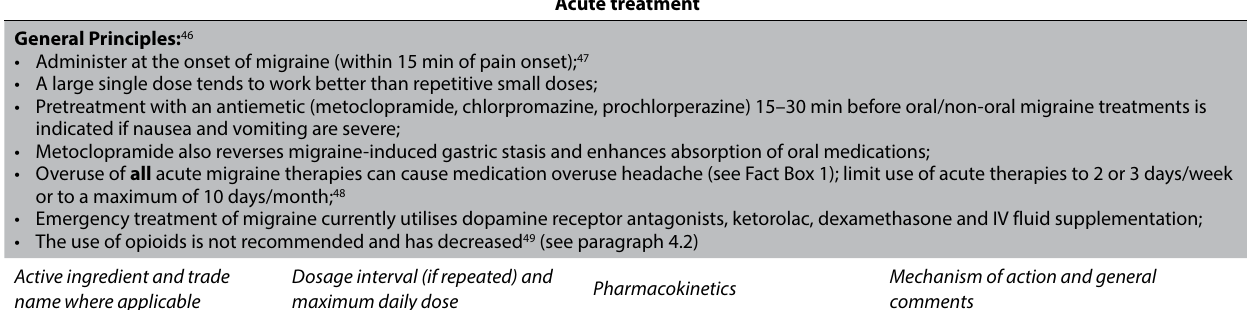
Table 1: Treatment indicated for acute intervention in migraine episodes